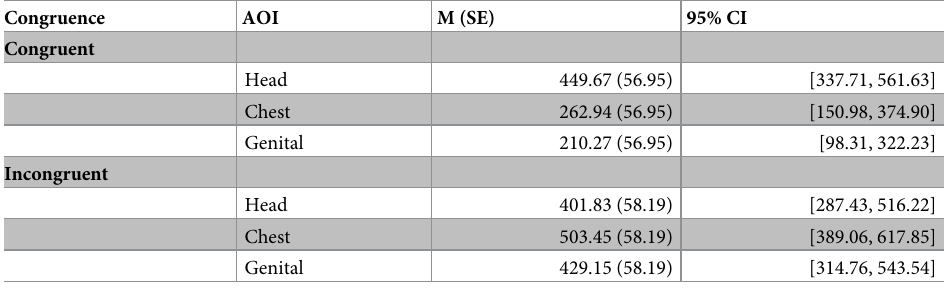
Table 4. Dwell time [ms] by stimulus congruence and AOI.